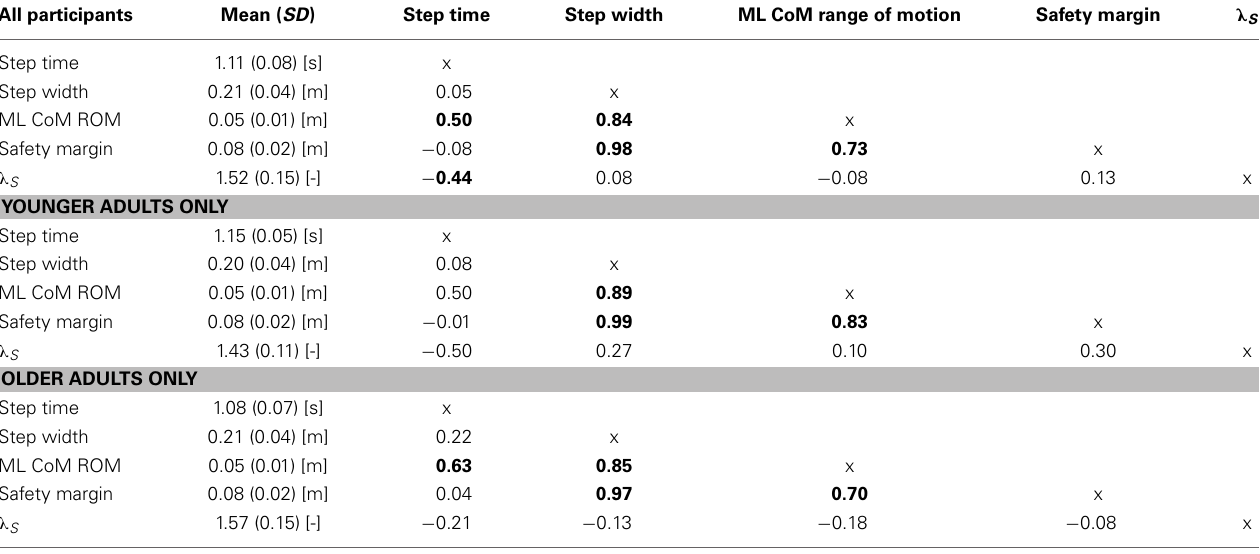
Table 1 | Means, standard deviations, and correlations between different gait parameters. All participants